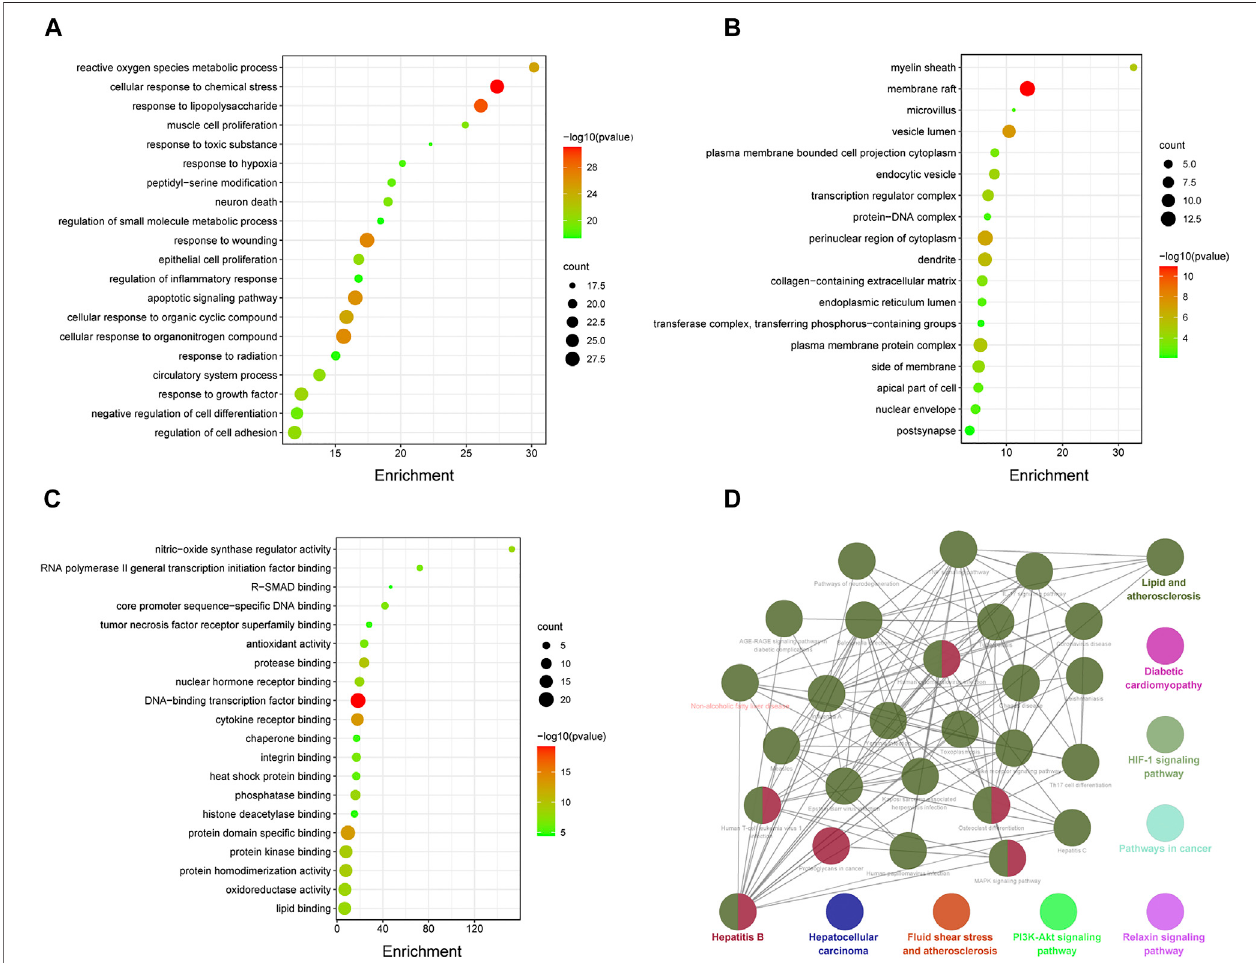
FIGURE 4 | Enrichment analysis of potential genes involved in the anti-NAFLD effects of HX. (A) Part of a GO functional analysis — biological process. (B) Part of a GO functional analysis — cellular components. (C) Part of a GO functional analysis — molecular functions. (D) Enriched KEGG pathways of potential targets of HX.